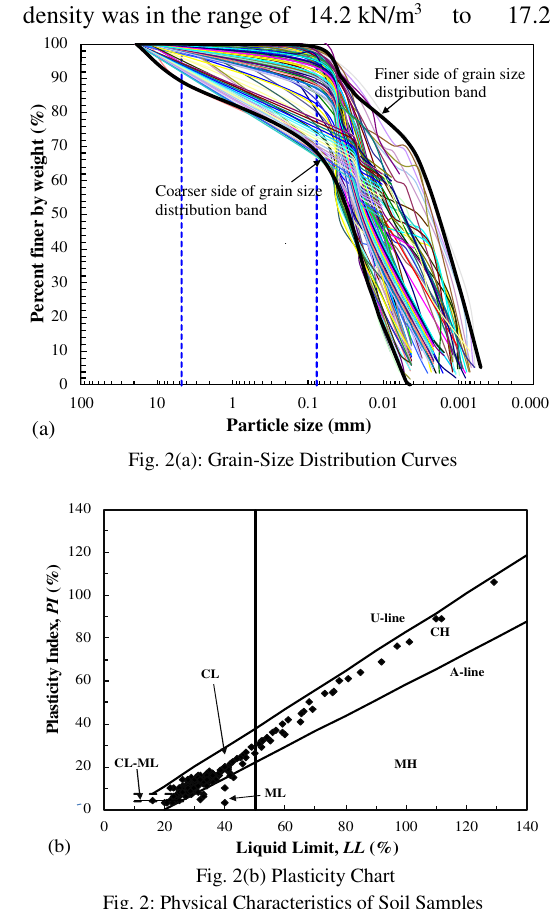
Fig. 2(b) Plasticity Chart Fig. 2: Physical Characteristics of Soil Samples kN/m 3 . At the same time, with the addition of bentonite in the soil, maximum dry density was observed to decrease, and optimum moisture content was increased. The decrease in dry density of soil samples can be attributed to the formation of the diffused double layer around the soil particles, which tends to enhance the effective soil particle size, due to high of fragment of active clay minerals present in the bentonite; consequently, it increases the void ratio and decreases the dry density of the soil. The compression index, coefficient of volume compressibility and compression ratio were determined from consolidation tests. The compression index was determined through the slope of the virgin curve obtained from the e-log(P) plot. Whereas, the m v value was determined for a pressure range of 100-200 kPa as per specifications of British standards (BS 1377) [45, 46]. It was